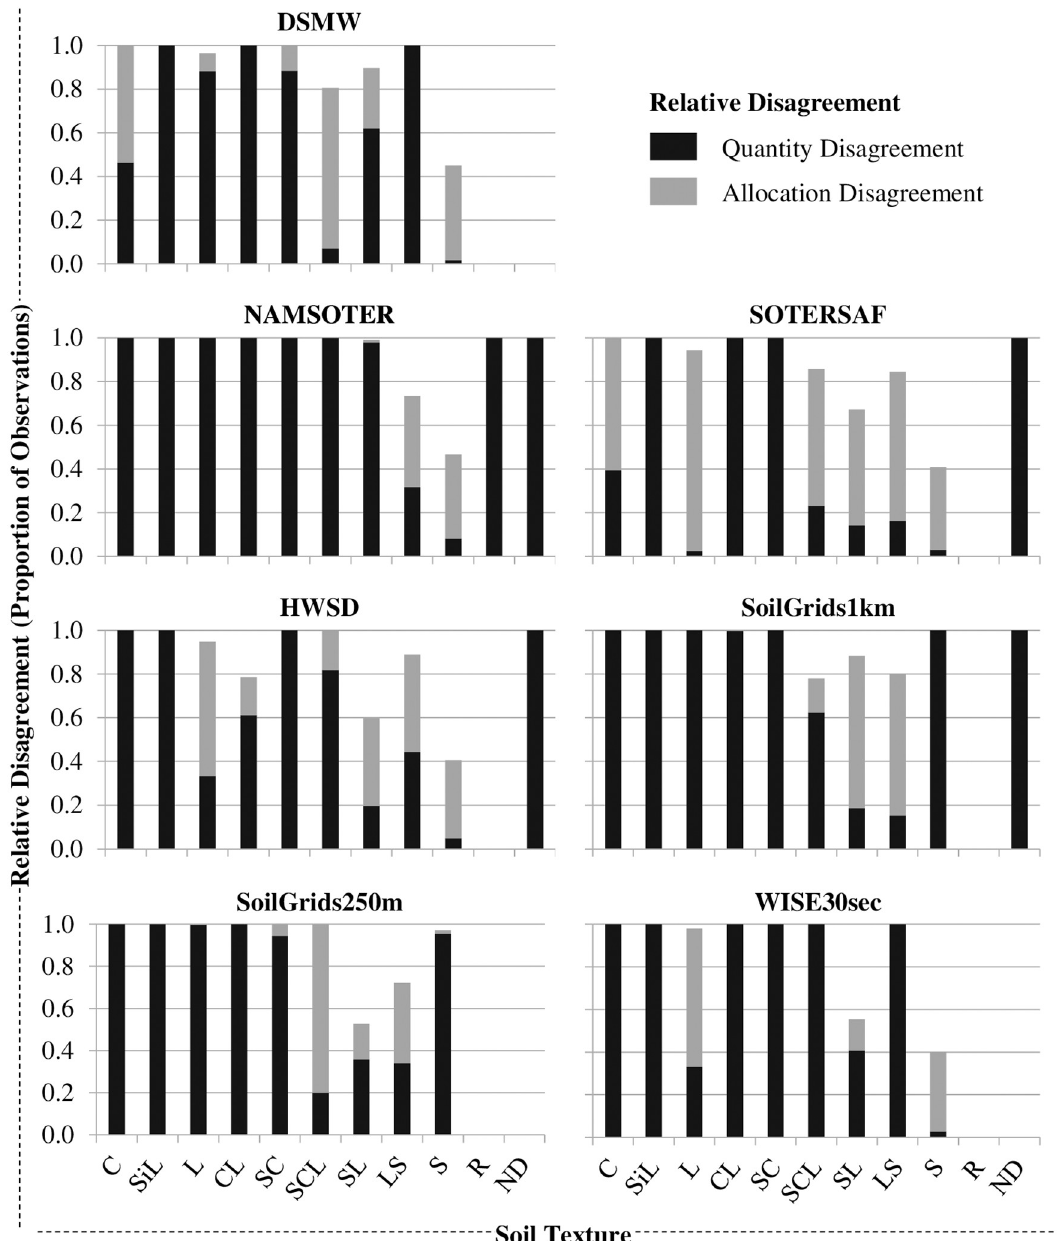
Fig 7. Relative disagreement between map and field data at the topsoil texture category level. See the section on “Topsoil Texture Map Accuracy Assessment” for a definition of relative disagreement. SiC, SiCL, and Si are not shown because these were not represented in any of the field samples or maps. Cases with complete relative quantity disagreement are those in which a soil texture was present in the field data and not the map data (i.e., C, SiL, L, CL, SCL, SL, LS, or S) or in which the map data included categories not present in the field data (i.e., R or ND). See the text for full names and versions of the map data